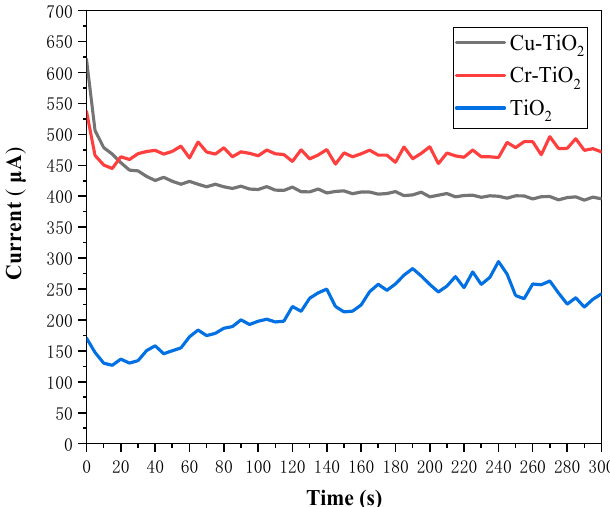
Figure 4. Charging currents of Cu-TiO 2 photoelectrodes, Cr-TiO 2 photoelectrodes and TiO 2 photo- electrodes in the Fe 2+ and Cr 3+ electrolytes.